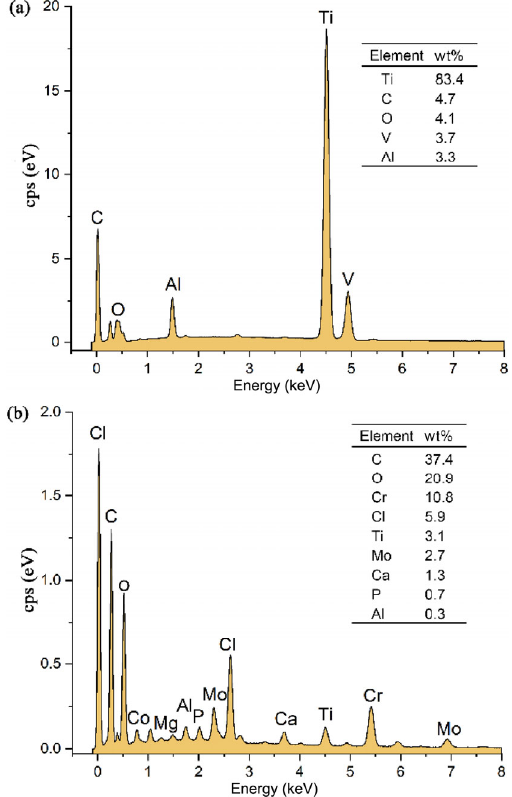
Fig. 10 EDS analysis of (a) unworn and (b) worn surfaces.